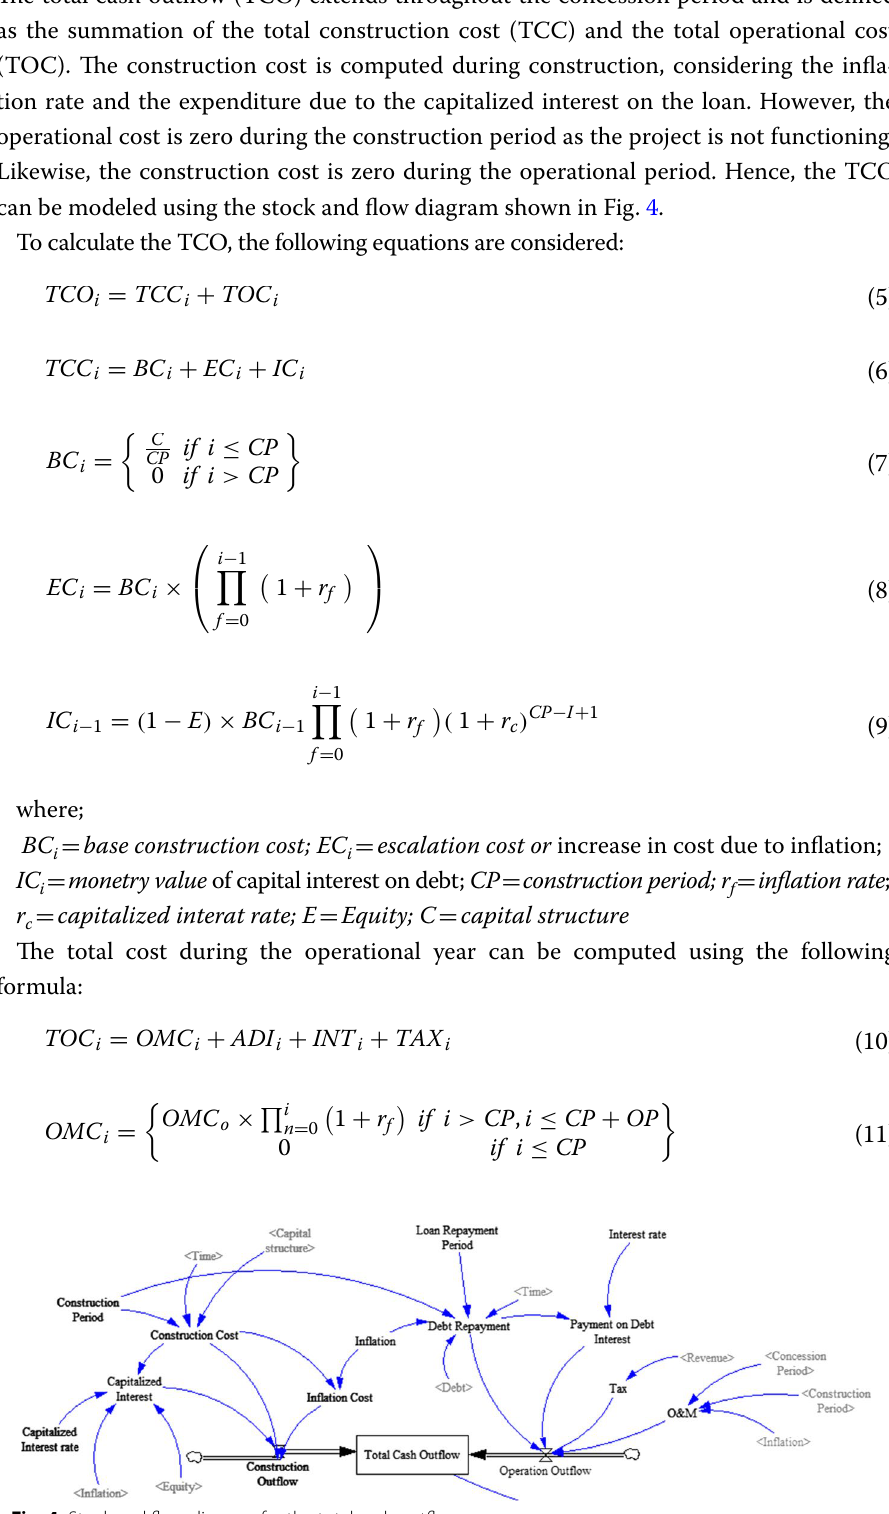
Fig. 4 Stock and flow diagram for the total cash